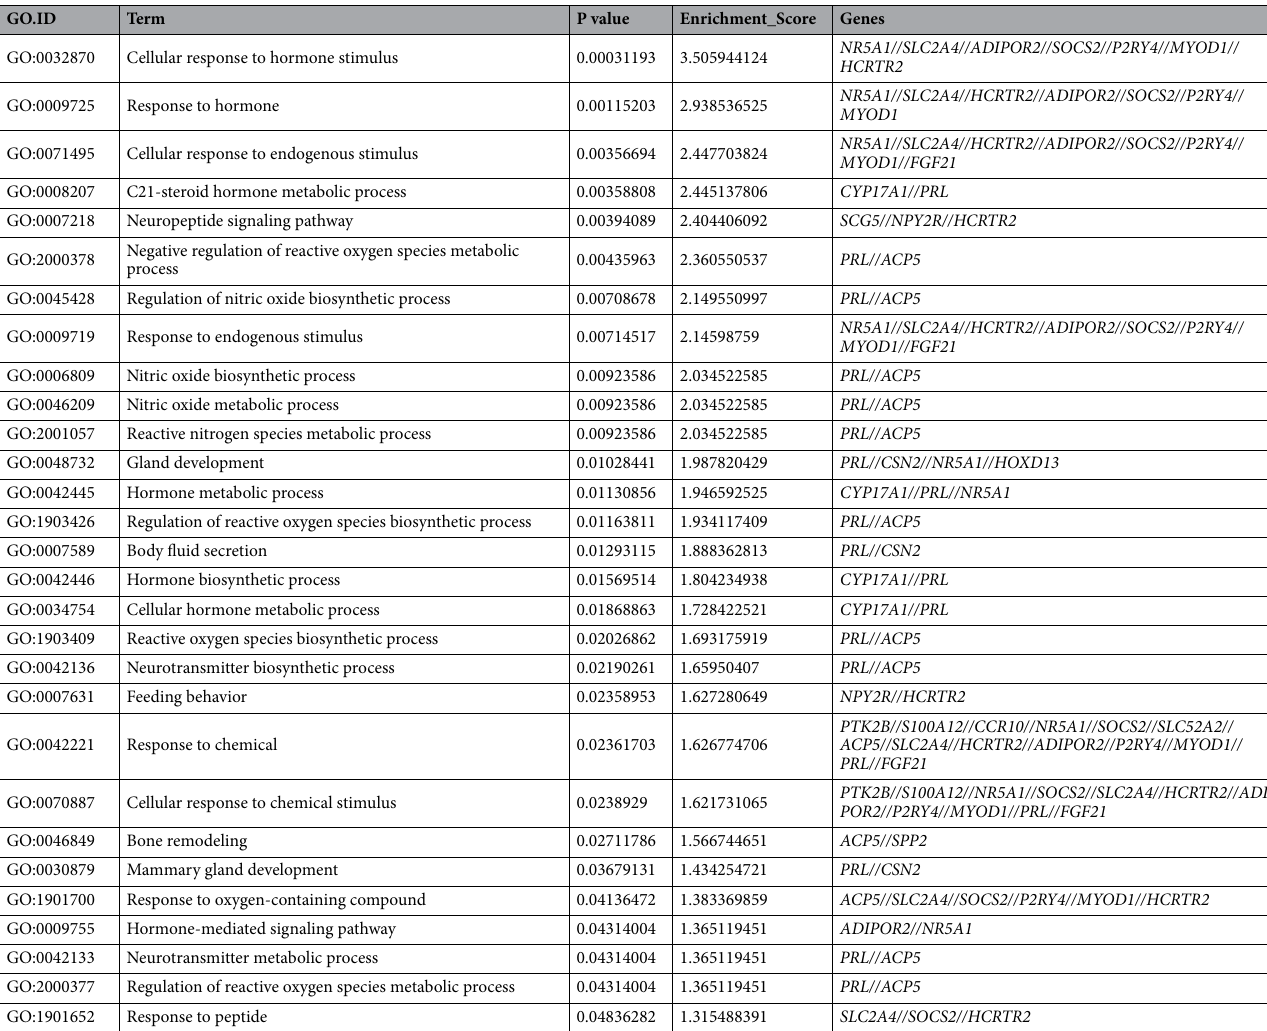
Table 3. The biological processes with up-regulated gene enrichment scores.